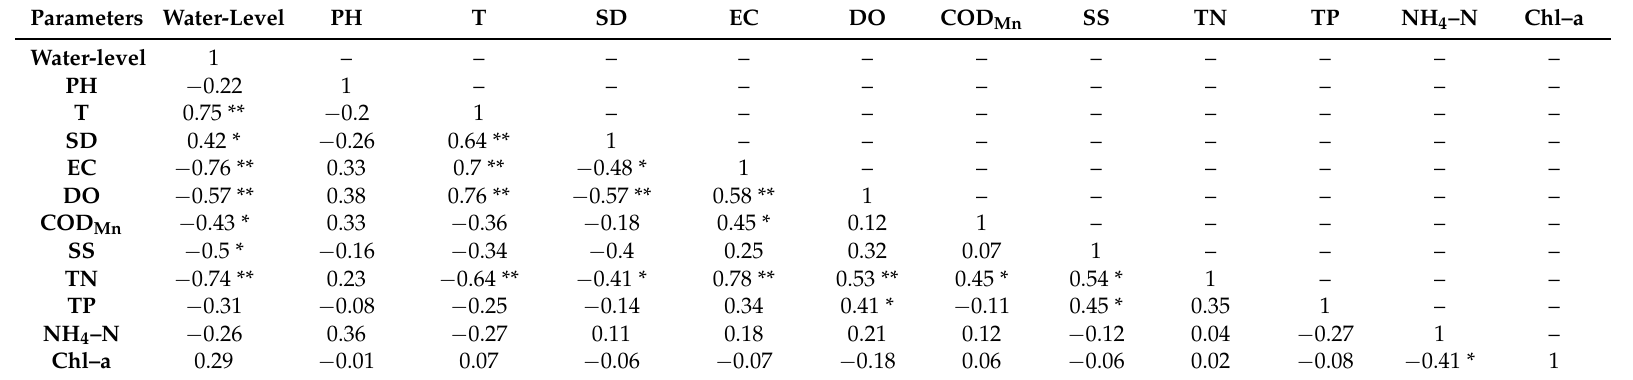
Table 1. Pearson’s correlation matrix for water-level and selected water quality parameters.